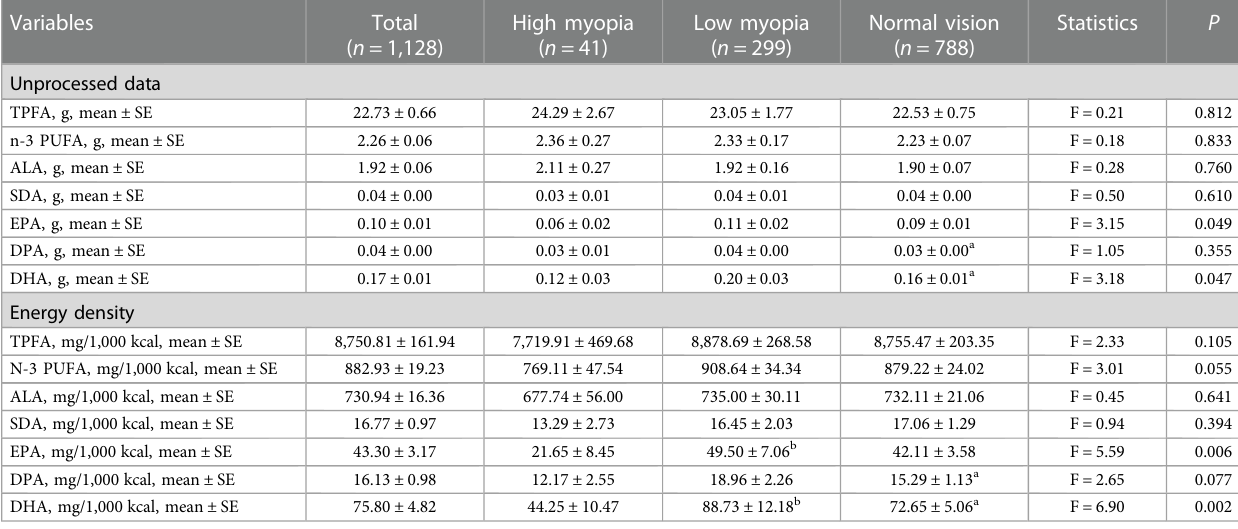
TABLE 2 Comparison for n-3 PUFA intake among juveniles with normal vision, low myopia, and high myopia.